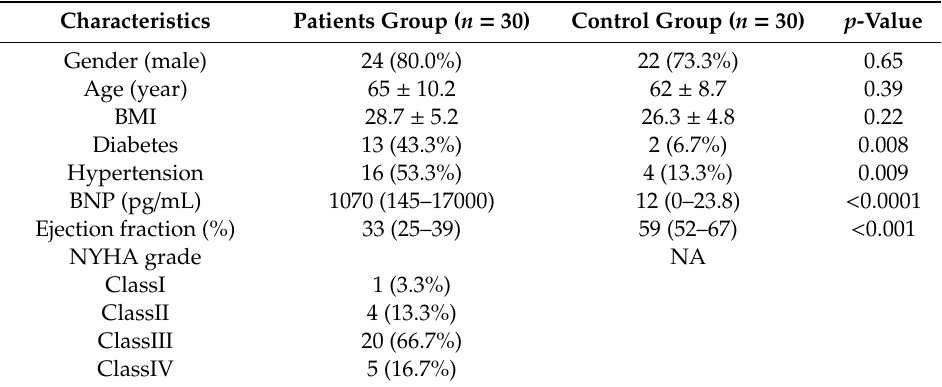
Table 1. The clinical features of heart failure (HF) patients and control